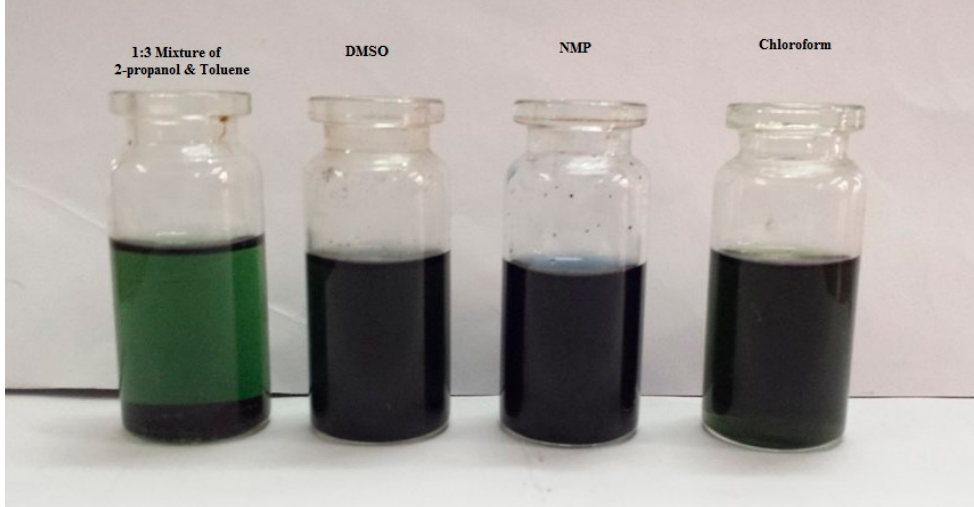
ff erent solvents as